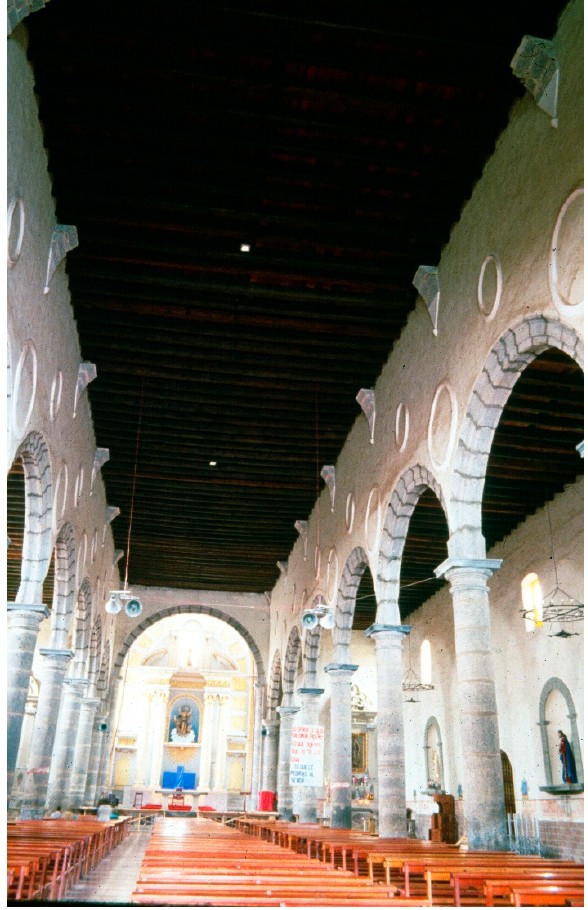
Figure 6. Interior of San Pedro and San Pablo church. Zacatlán de las Manzanas. Photo took by author.